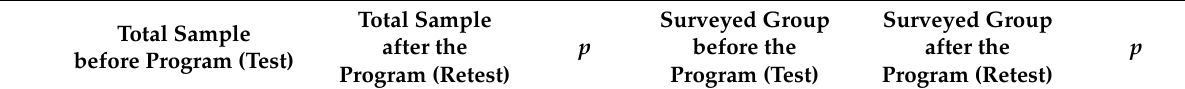
Table 5. Comparision of food consumption frequency (times/day) of various food products in the studied population and in the surveyed group before and after the 6-month nutrition education